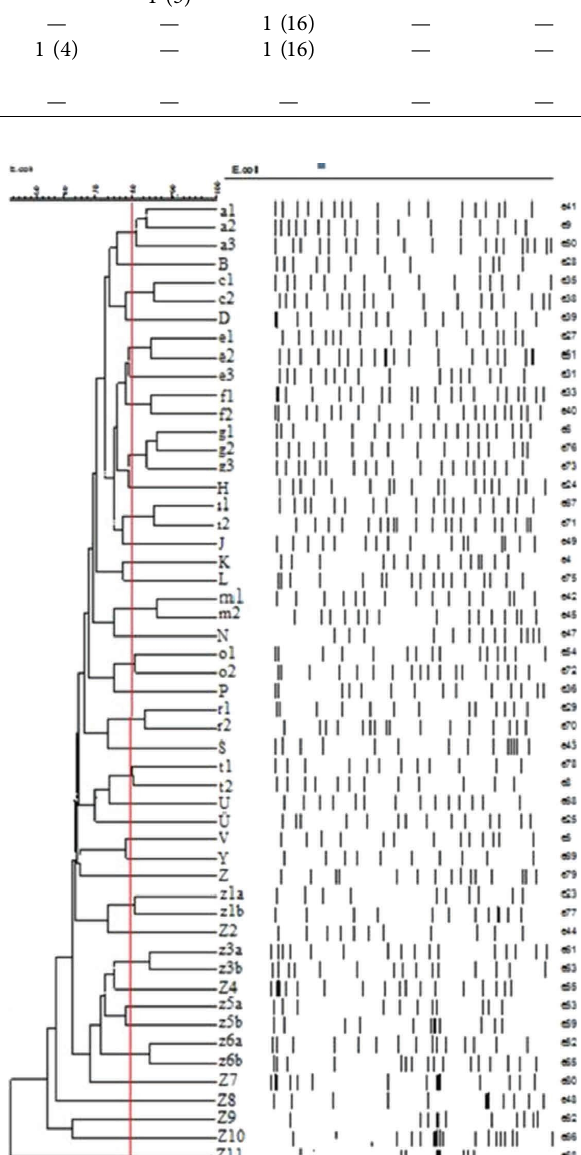
Figure 6: Simple dendogram of